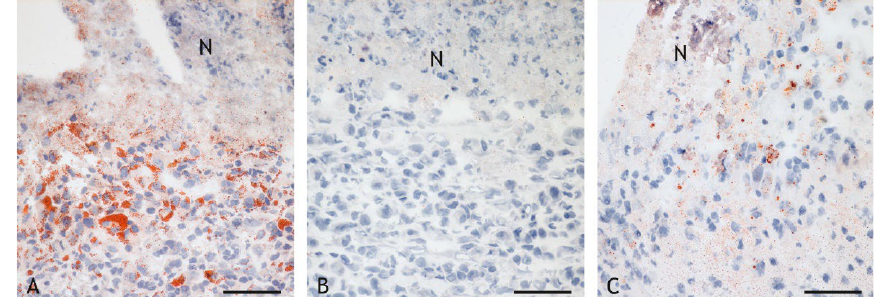
Figure 6. Lipid droplets in foam cells of caseous granulomas. ( A ). BCG-induced granuloma, goat 22: Many epithelioid cells and MNGCs adjacent to the necrosis (N) contain numerous lipid droplets (red). Lipid droplets are also present in the necrosis. ( B ). VPM1002-induced granuloma (goat 9): There are no lipid droplets present adjacent to or in the necrosis. ( C ). NUOG-induced granuloma (goat 20): A Sudan III stain. Scale bars = 50 µ